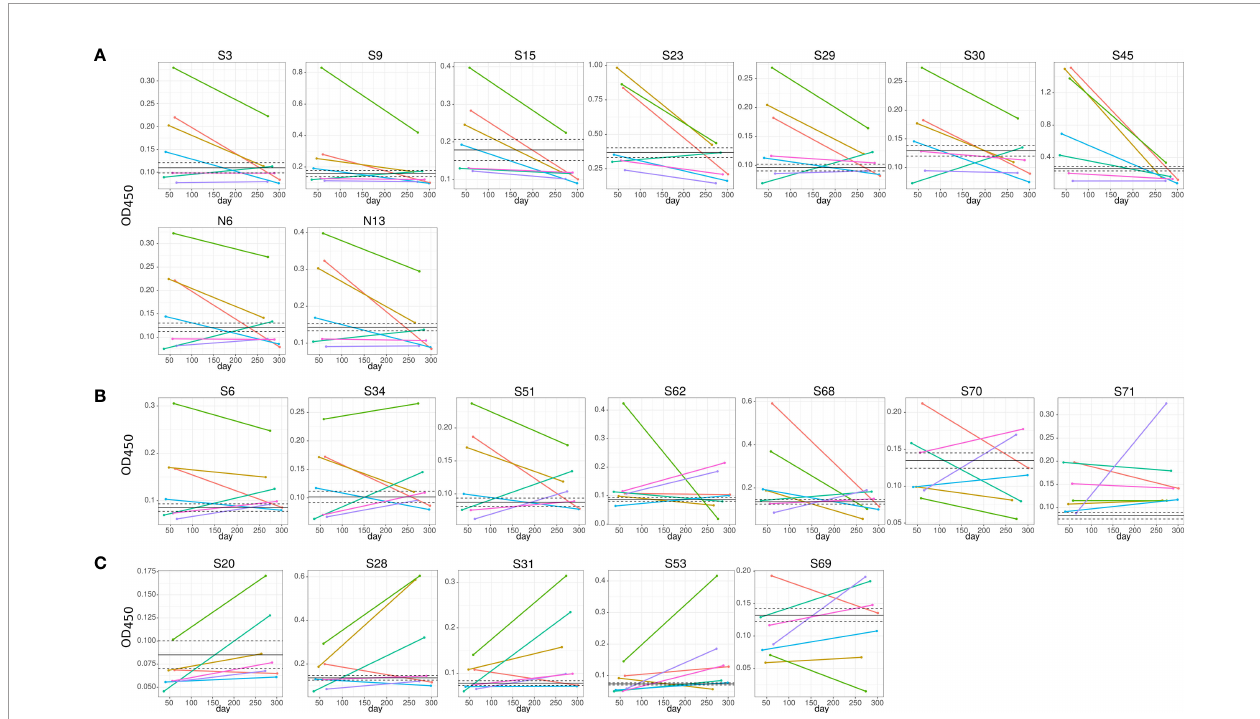
FIGURE 4 | Dynamics of convalescent COVID-19 IgG antibody reactivity with SARS-CoV-2 S protein peptides. Serum from early (median 42.0±11.1) and late (median 306.0±21.1) convalescent COVID-19 was used for analysis. IgG reactivity with SARS-CoV-2 S protein peptides was analyzed using ELISA. (A) IgG reactivity decreased in 5 out of 7 COVID-19 convalescent serum with time post infection; (B) reactivity with peptides remained mostly unchanged; (C) IgG reactivity increased in 5 out of 7 COVID-19 convalescent serum with time post infection. Lines represent individual COVID-19 convalescent sample. S6, S15, S20, S31, S34 and S45 – are SARS-CoV-2 S protein